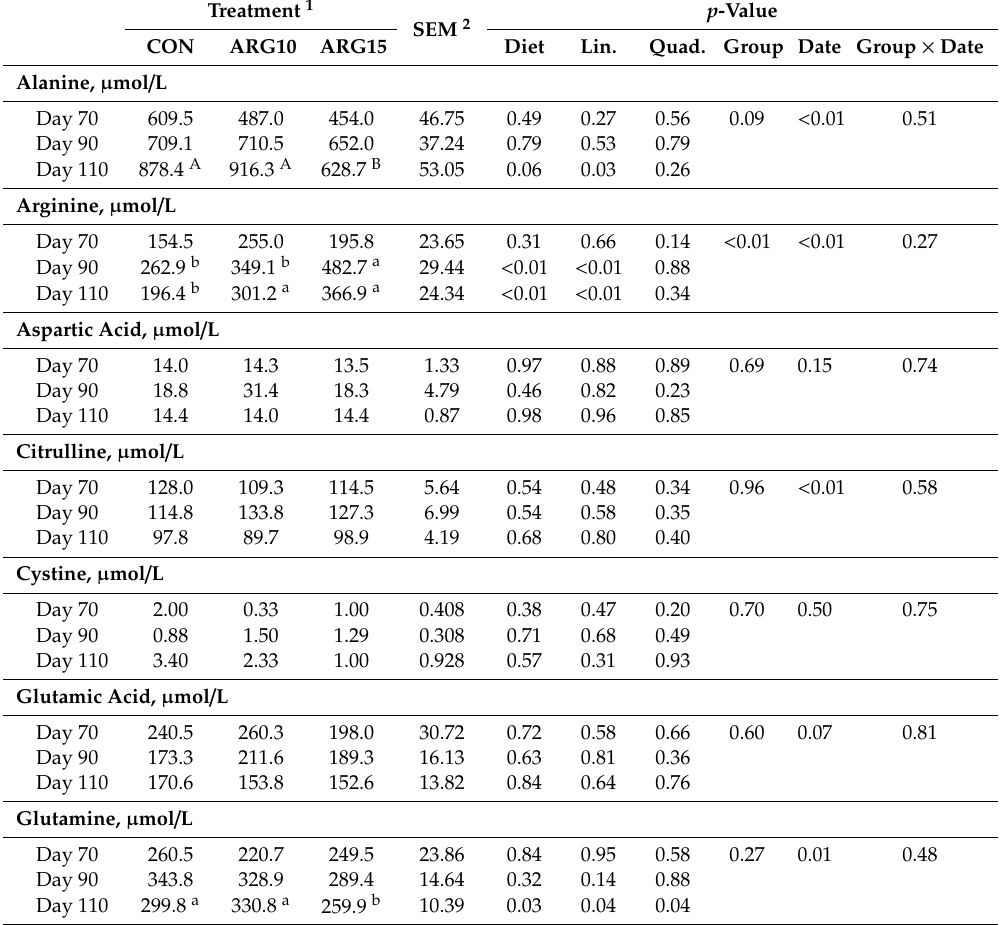
Table 6. E ff ects of arginine supplementation levels on plasma amino acid profile in late-gestating sows. p -Value Treatment 1 SEM 2 CON ARG10 ARG15 Diet